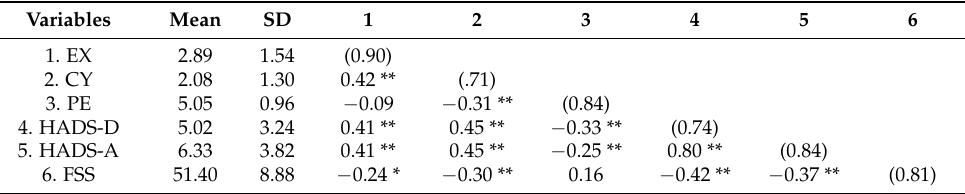
Table A6. Mean Scores, Standard Deviations (SD), Cronbach’s’ α and Correlation Coefficients among the three MBI subscales, HADS and FSS scores ( n =